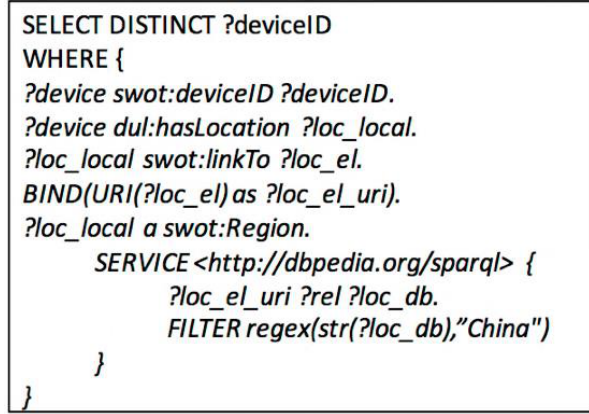
Figure 8. The SPARQL query of a semantic fuzzy search on common sense knowledge.